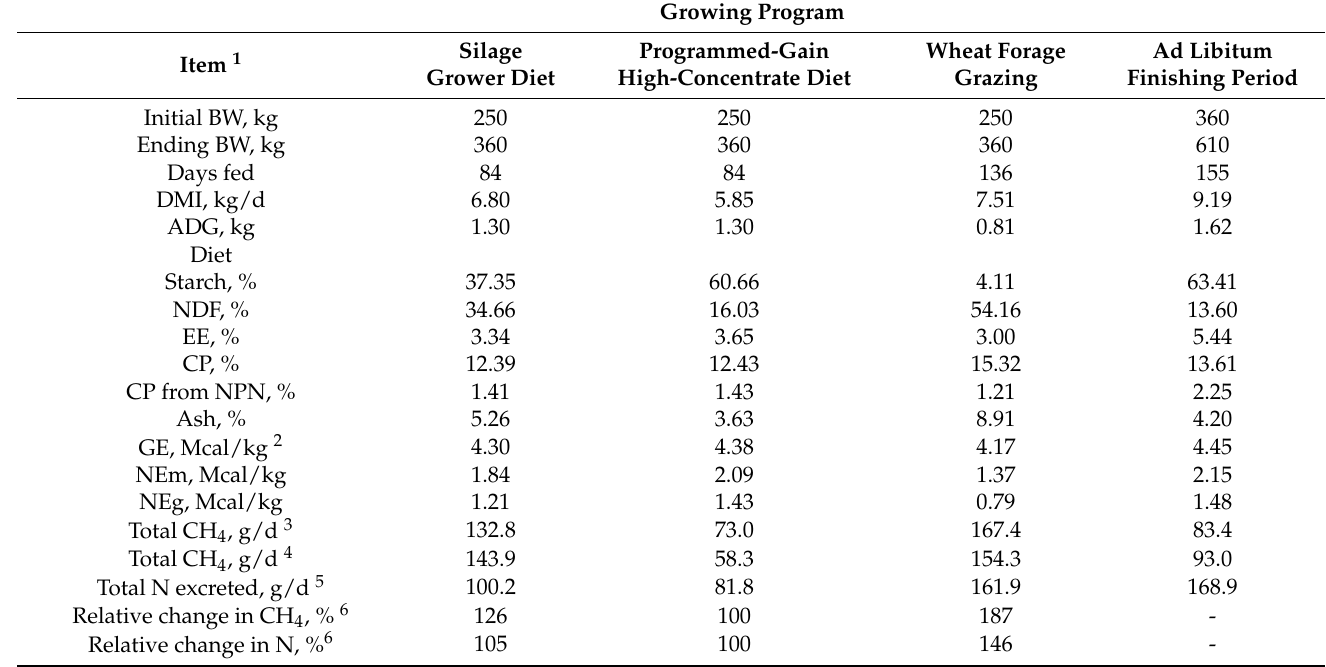
Table 1. Effects of traditional high-roughage growing programs vs. a programmed-gain high- concentrate growing program followed by an ad libitum finishing period on estimated enteric emission of methane and excretion of nitrogen in feedlot beef